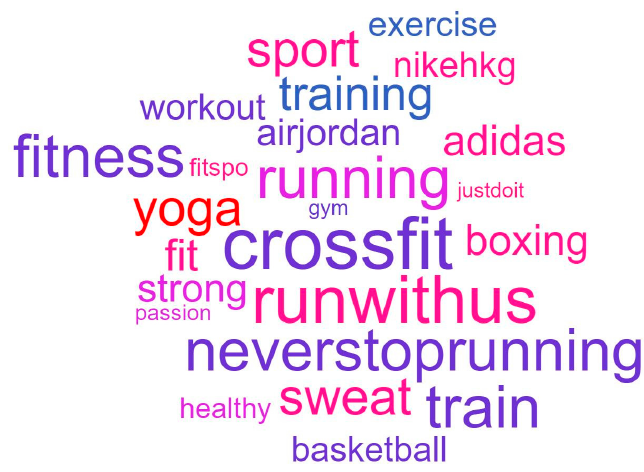
Figure 7. The word cloud for representative hashtags of a ’fitness’ community.